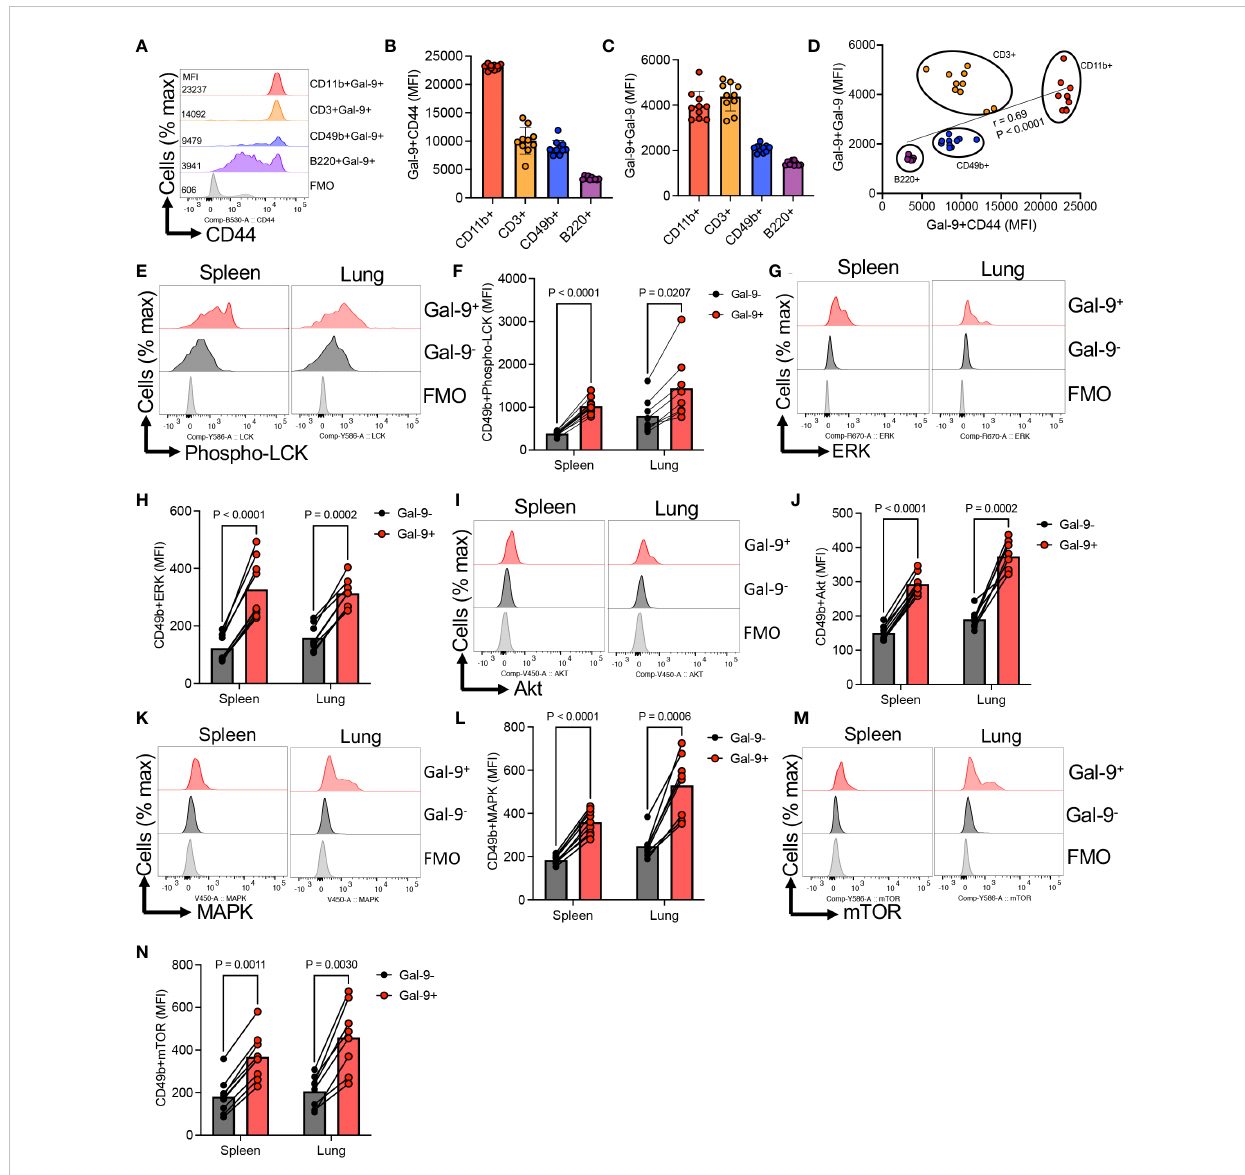
FIGURE 4 Gal-9 interaction with CD44 results induces NK cell activation. (A) Representative histogram, and (B) cumulative data of the mean fl uorescence intensity (MFI) of CD44 expression in CD11b, CD49b, B220, and CD3 T cells from the spleen of adult BALB/c mice. (C) Cumulative data showing the MFI of Gal-9 expression in Gal-9 + CD11b, CD49b, B220, and CD3 T cells from the spleen of adult BALB/c mice. (D) Showing the correlation between the intensity of Gal-9 with the intensity of CD44 expression in different indicated immune cells from the spleen of adult BALB/c mice. (E) Representative histogram plots, and (F) cumulative data of the intensity of Phospho-LCK expression in Gal-9 + versus Gal-9 - NK cells in the spleen and lung of adult BALB/c mice. (G) Representative histogram plots, and (H) cumulative data of the intensity of ERK expression in Gal-9 + versus Gal- 9 - NK cells in the spleen and lung of adult BALB/c mice. (I) Representative histogram plots, and (J) cumulative data of the intensity of Akt expression in Gal-9 + versus Gal-9 - NK cells in the spleen and lung of adult BALB/c mice. (K) Representative histogram plots, and (L) cumulative data of the intensity of MAPK expression in Gal-9 + versus Gal-9 - NK cells in the spleen and lung of adult BALB/c mice. (M) Representative histogram plots, and (N) cumulative data of the intensity of mTOR expression in Gal-9 + versus Gal-9 - NK cells in the spleen and lung of adult BALB/c mice. Each dot represents data from an animal, mean ± SEM from multiple independent experiments. Infection study (O&P) from two independent experiment. Fluorescence minus one